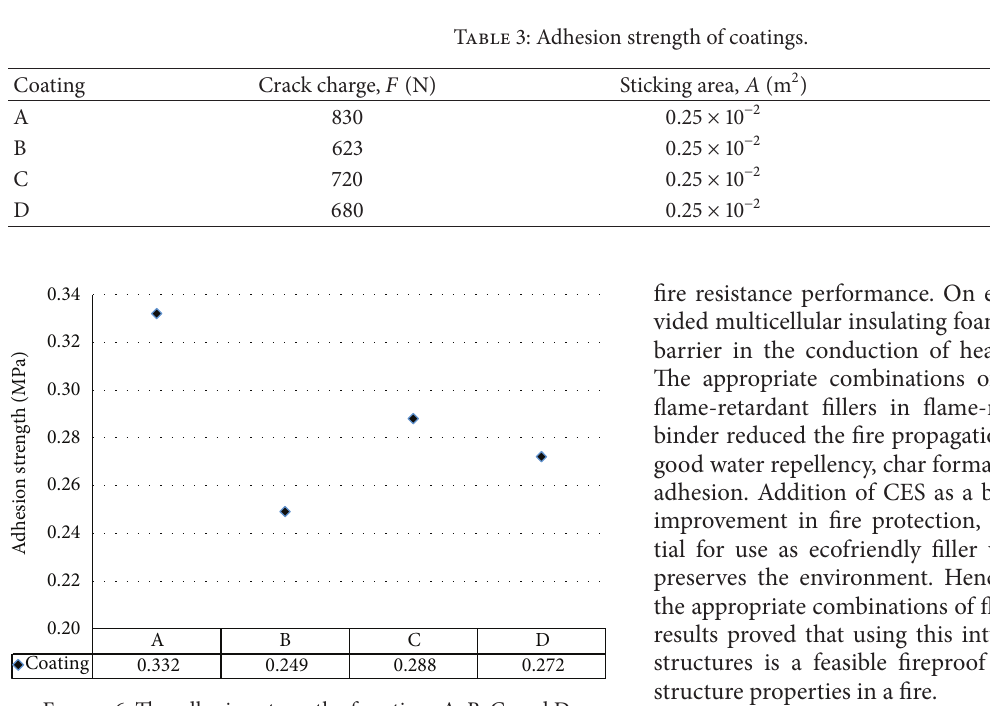
Figure 6: The adhesion strength of coatings A, B, C, and